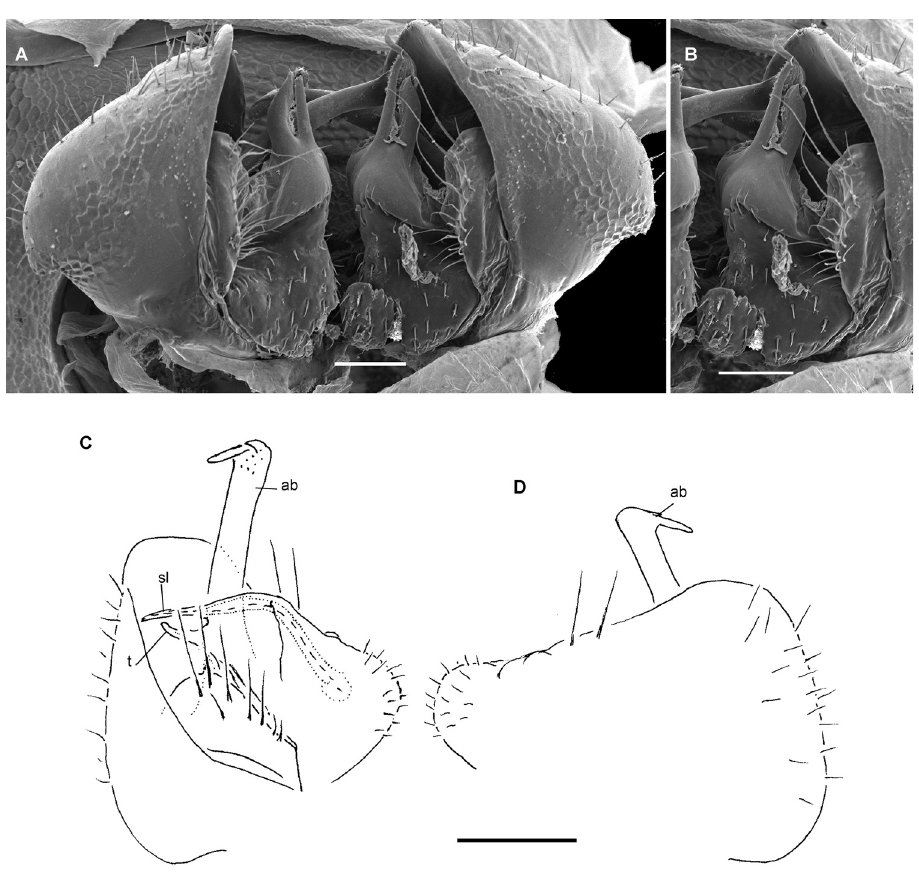
Figure 18. Hemisphaeroparia bonakanda sp. n., ♂ paratype A SEM micrographs of both gonopods in situ, ventral view B SEM micrographs of right gonopod, ventral view C, D left gonopod of holotype, mesal and lateral views, respectively. Scale bars: 0.1 mm ( C, D ), 0.05 mm ( A, B ). Abbreviations: ab apical branch of telopodite, sl solenomere, t